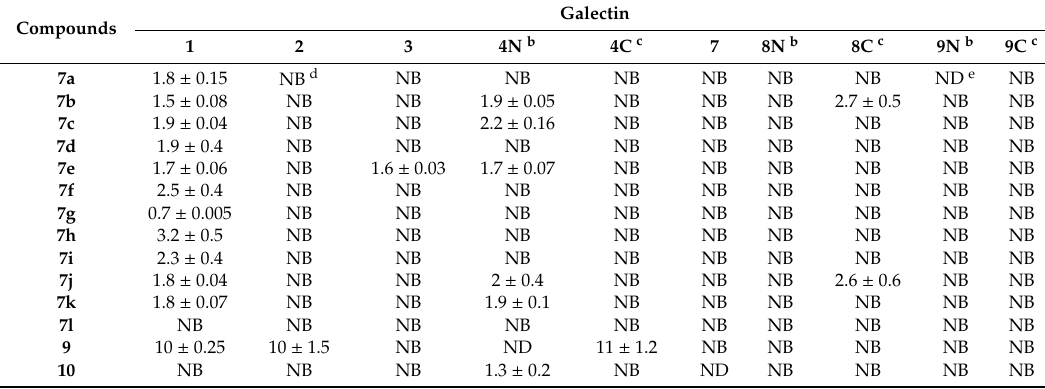
Figure 2. Structures of all tested compounds 7a – 7l and 9 – 10 . Table 2. K d -values (mM) a of compounds 7a – 7l , 9 , and 10 against human galectin-1, 2, 3, 4N, 4C, 7, 8N, 8C, 9N, and 9C in a competitive fluorescence polarization assay.